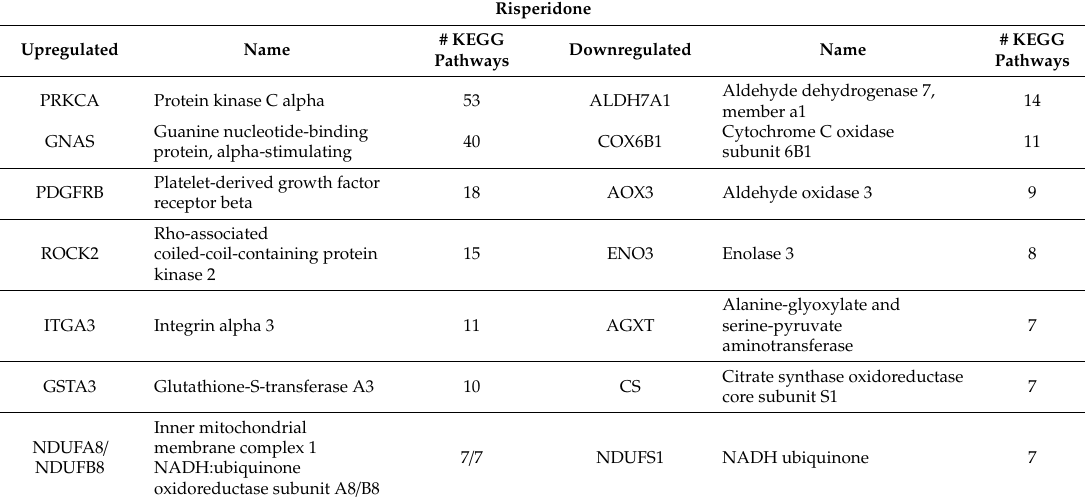
Table 3. Significantly overrepresented proteins di ff erentially expressed in livers from animals treated with risperidone or